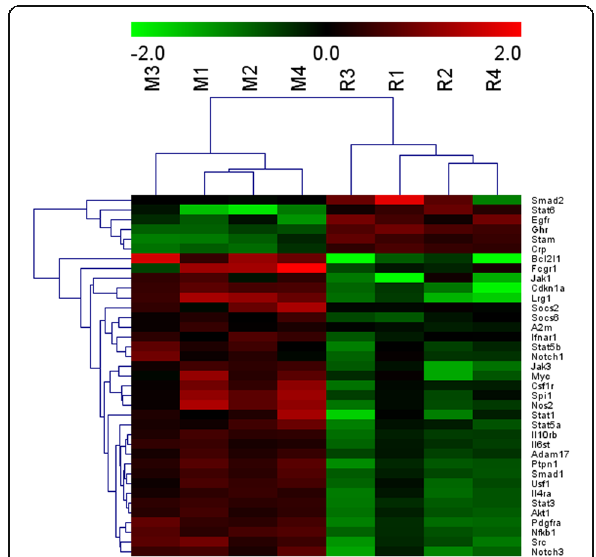
Fig. 3 Heatmap of the expression profiles of the differentially expressed mRNAs in mice. Blue to red indicate the low to high expression levels. The column labels at the right represent the differentially expressed mRNAs in the JAK-STAT signaling pathway. M represents the BLM-treated model, and R represents the FFK-treated